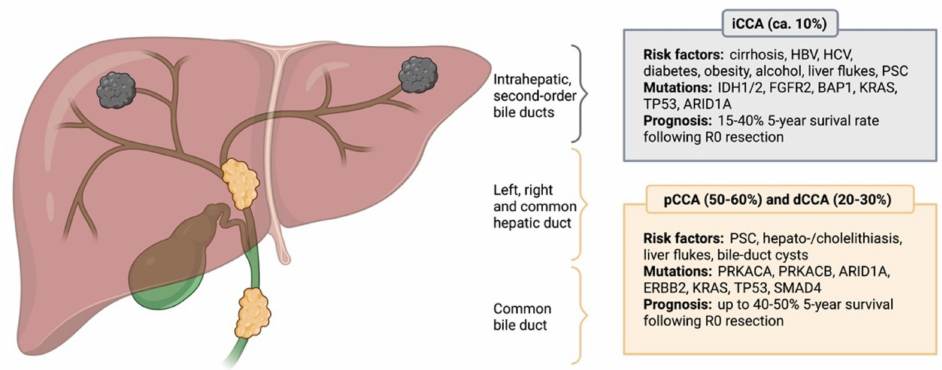
Figure 1. Anatomical classification of cholangiocarcinoma. CCA is anatomically divided into intra- hepatic (iCCA), perihillar (pCCA) and distal (dCCA) cholangiocarcinoma, with pCCA and dCCA being summarized as extrahepatic cholangiocarcinoma (eCCA). Different CCA subtypes possess distinct molecular aberrations and differ in terms of their etiology, while certain risk factors and genetic mutations are not subtype-specific. The most common risk factors and prevailing genetic alterations are presented. HBV: Hepatitis B virus; HCV: Hepatitis C virus; PSC: Primary sclerosing cholangitis; IDH1/2: Isocitrate dehydrogenase 1/2; FGFR2: Fibroblast growth factor receptor 2; BAP1: BRCA1 associated protein 1; KRAS: Kirsten rat sarcoma virus; TP53: Tumor suppressor protein 53; ARID1A: AT-rich interactive domain-containing protein 1A; PRKACA: Protein kinase cAMP-activated catalytic subunit alpha; PRKACB: Protein kinase cAMP-activated catalytic subunit beta;